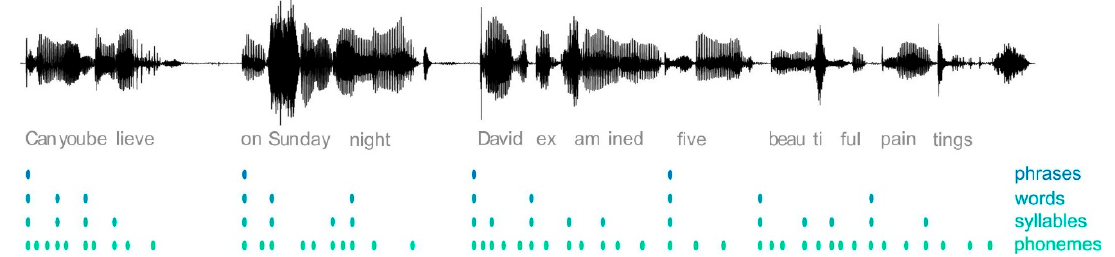
Figure 2. Acoustic waveform with its segmentation into phrases, words, syllables, and phonemes. Figure reproduced from [48].